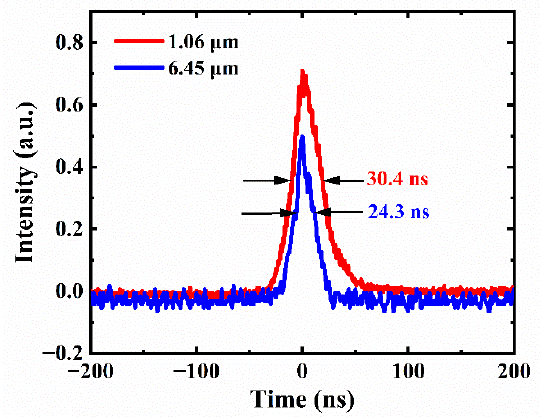
Figure 5. Measured temporal profiles of the incident pump and idler